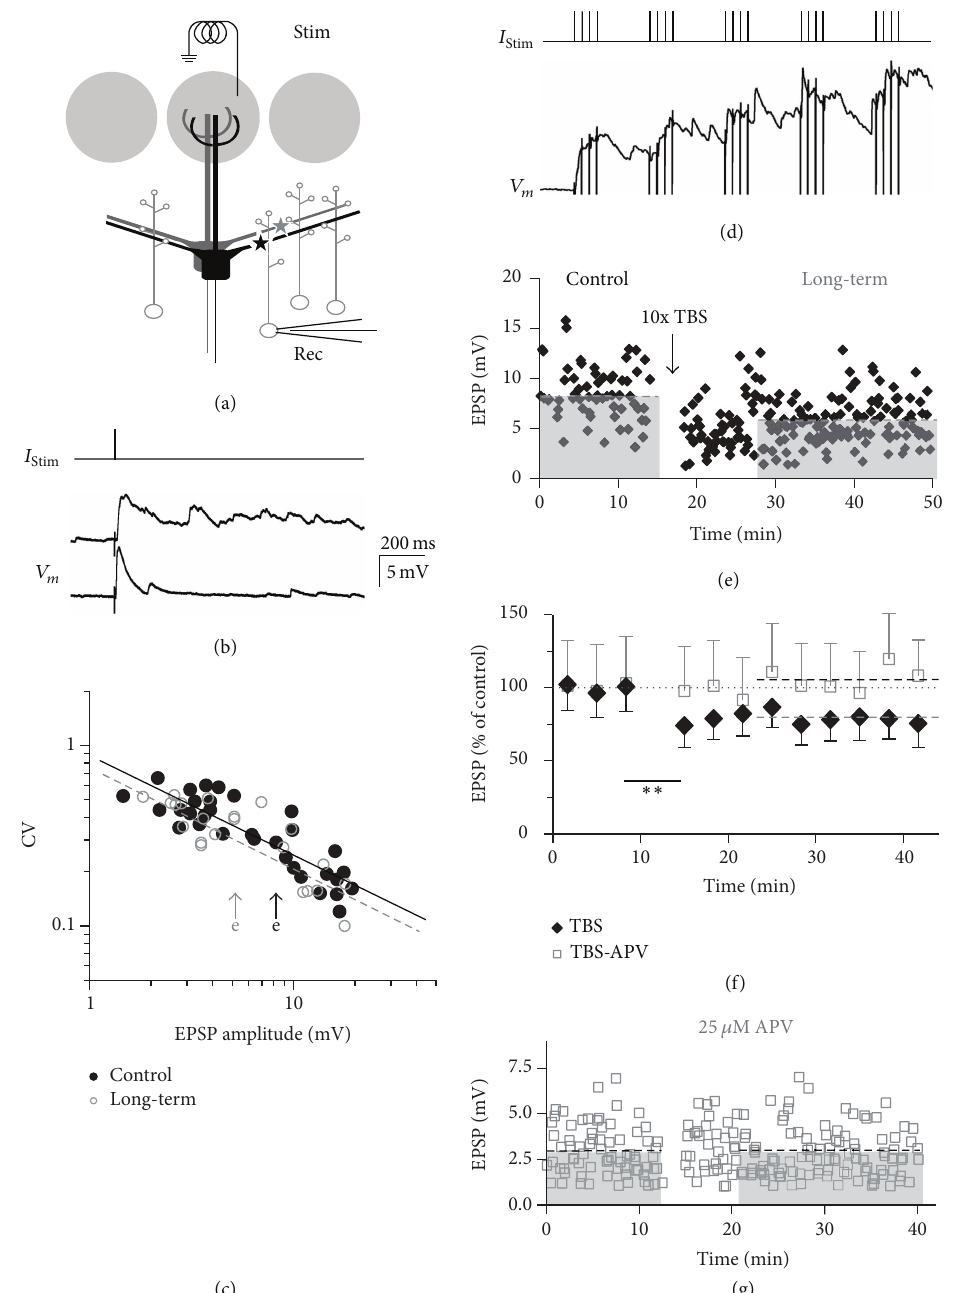
Figure1: TBSinduces LTD attheMTC-GCsynapse. (a) Experimental design[25]. Glomerular stimulation(Stim)will activate theglomerular ensemble of mitral cells to a varying extent (depending on stimulation strength); thus inputs from several mitral cells onto the recorded GC (Rec) will be activated. (b) Response of individual granule cell to single glomerular stimulation (two individual responses shown, note the barrage of activity in the second response). (c) Coefficients of variation of EPSP amplitude of synaptic connections versus their mean EPSP amplitude for control data (black dots) and long-term data (grey circles). For control, the fit has a slope of −0.55±0.06 (mean ± SD) on the log scale (black line) and for long-term the slope was −0.56 ± 0.08 . The confidence intervals were calculated from 𝑛 = 200 bootstrap replicas of the data. The arrows mark the data points from the connection shown in (e). (d) Response of the cell from (b) to TBS (average of the total of 10 stimulations). (e) EPSP amplitudes from individual GC recordings from the cell in (b) and (d) over time. Control mean 8.1mV; long-term mean 6.3 mV (dashed lines). (f) Cumulative data (normalized to control) of all experiments with substantial LTD (black diamonds, 𝑛 = 10 ) and of all experiments in the presence of 25 𝜇 M APV (grey squares, 𝑛 = 6 ). Respective long-term averages shown as dashed lines (grey for TBS and black for TBS in APV). All data points ± SD across experiments. (g) Representative individual experiment in the presence of 25 𝜇 M APV. Control mean 2.9 mV; long-term mean 2.7 mV (dashed black lines). ∗∗ The degree of the statistical difference between the last data point before TBS and the first data point after TBS (black